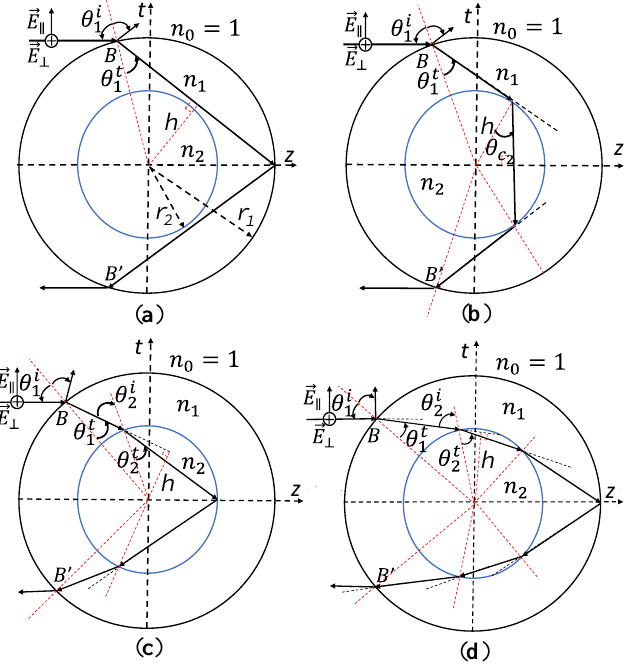
Figure 3. Backscattered waves of the oblique incident wave from LCS for: ( a